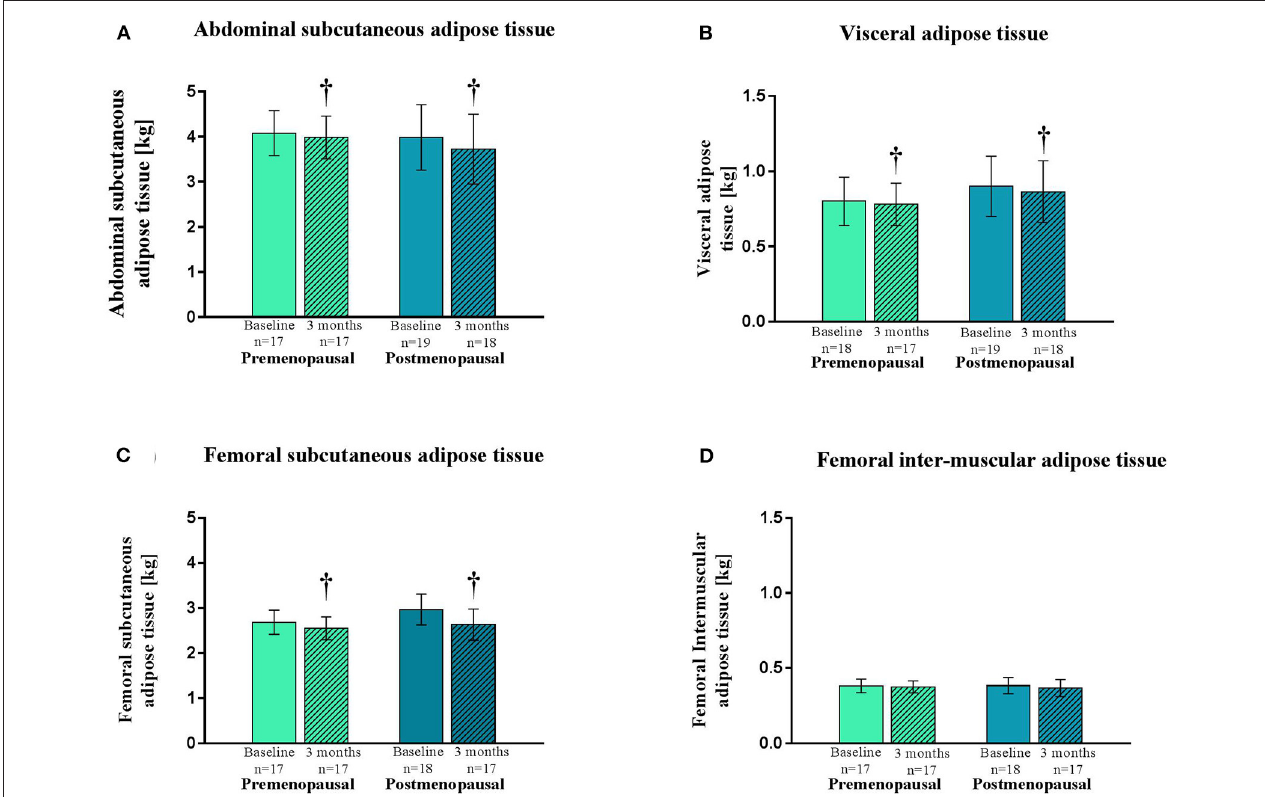
FIGURE 1 | Abdominal and femoral adipose tissue depots as determined by magnetic resonance imaging in pre- and post-menopausal women before and after 3 months of high-intensity training. Data are presented as mean (95% confidence limits). Changes from baseline to 3 months † p ≤ 0.05. (A) Abdominal subcutaneous adipose tissue. (B) Visceral adipose tissue. (C) Femoral subcutaneous adipose tissue. (D) Femoral inter-muscular adipose tissue.